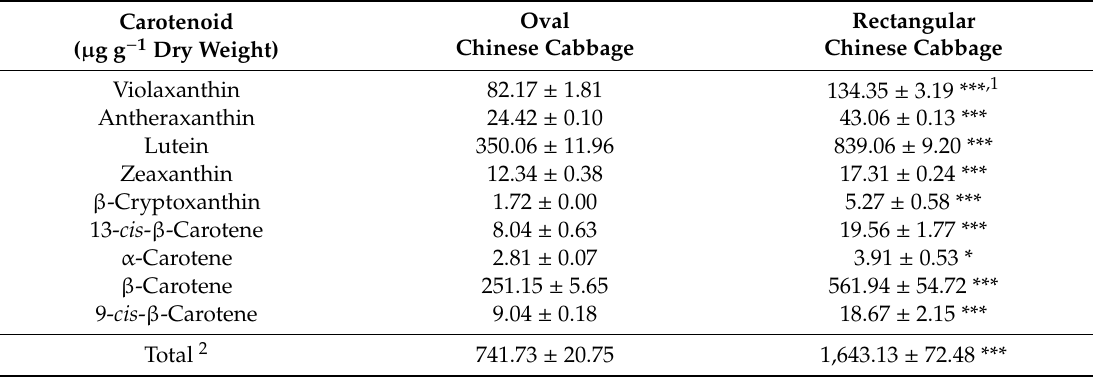
Table 3. Carotenoid contents in oval and rectangular Chinese cabbage.